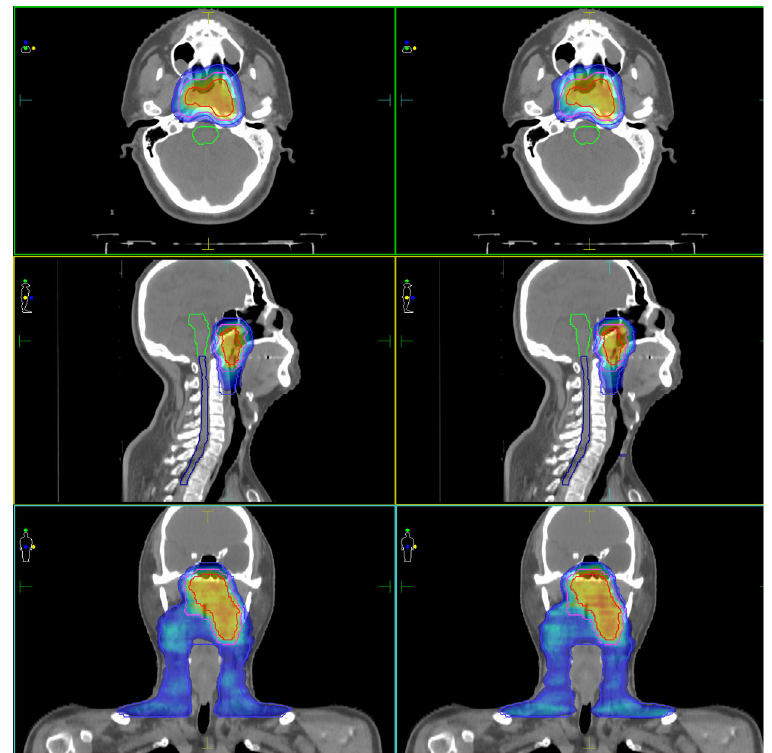
Figure 1. Isodose distributions for a representative NPC patient (stage cT1N2M0) in the volumetric modulated arc therapy (VMAT) plan (left) and step and shoot intensity modulated radiation therapy (s-IMRT) plan (right), indicating the PTV-7000 (red), PTV-6000 (pink), PTV-5600 (light blue). doi: